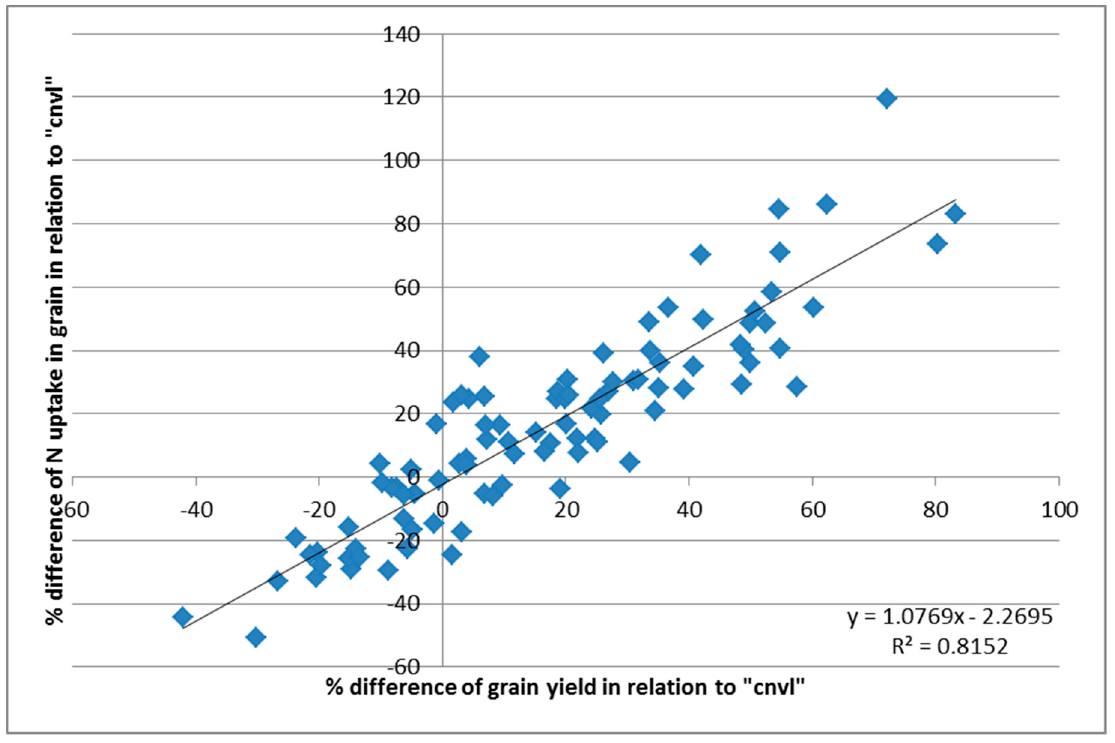
Figure 2. Correlation between the percentage difference of grain yield in relation to “cnvl” and the percentage difference of the total N uptake by grain during the “test years” of the experiment. Paired data were calculated from results that were obtained inside the same block (see Figure 3).